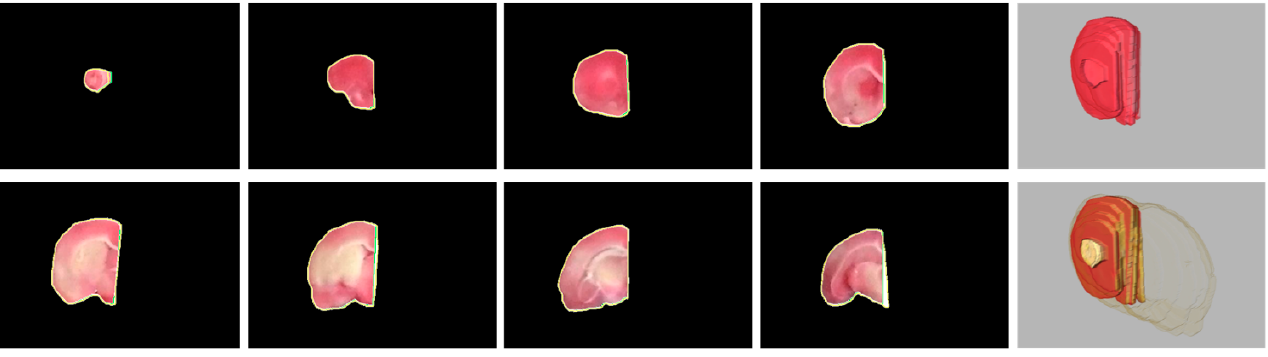
Figure 8. Visual comparison between the rat hemisphere segmentation contours (green) and the gold standard outlines (yellow). From top left, the κ c values were 88.58%, 97.58%, 97.01%, 97.24%, 98.03%, 96.26%, 98.78% and 92.79%, respectively. Top right: 3-D view of the segmented right hemisphere, κ c = 96.77%. Bottom right: 3-D view of the segmented hemisphere superimposed with the gold standard, κ D = 98.41%. Table 3. Quantitative performance analyses of the rat hemisphere segmentation results in the TTC- stained image dataset based on similarity measure metrics.